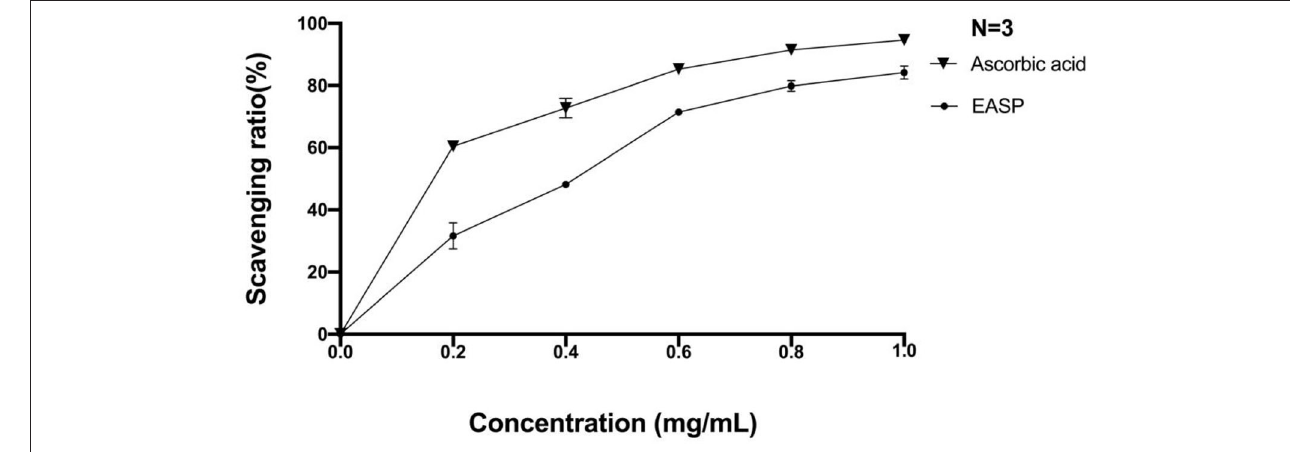
FIGURE 4 | Scavenging effects of EAPS on hydroxyl free radical.